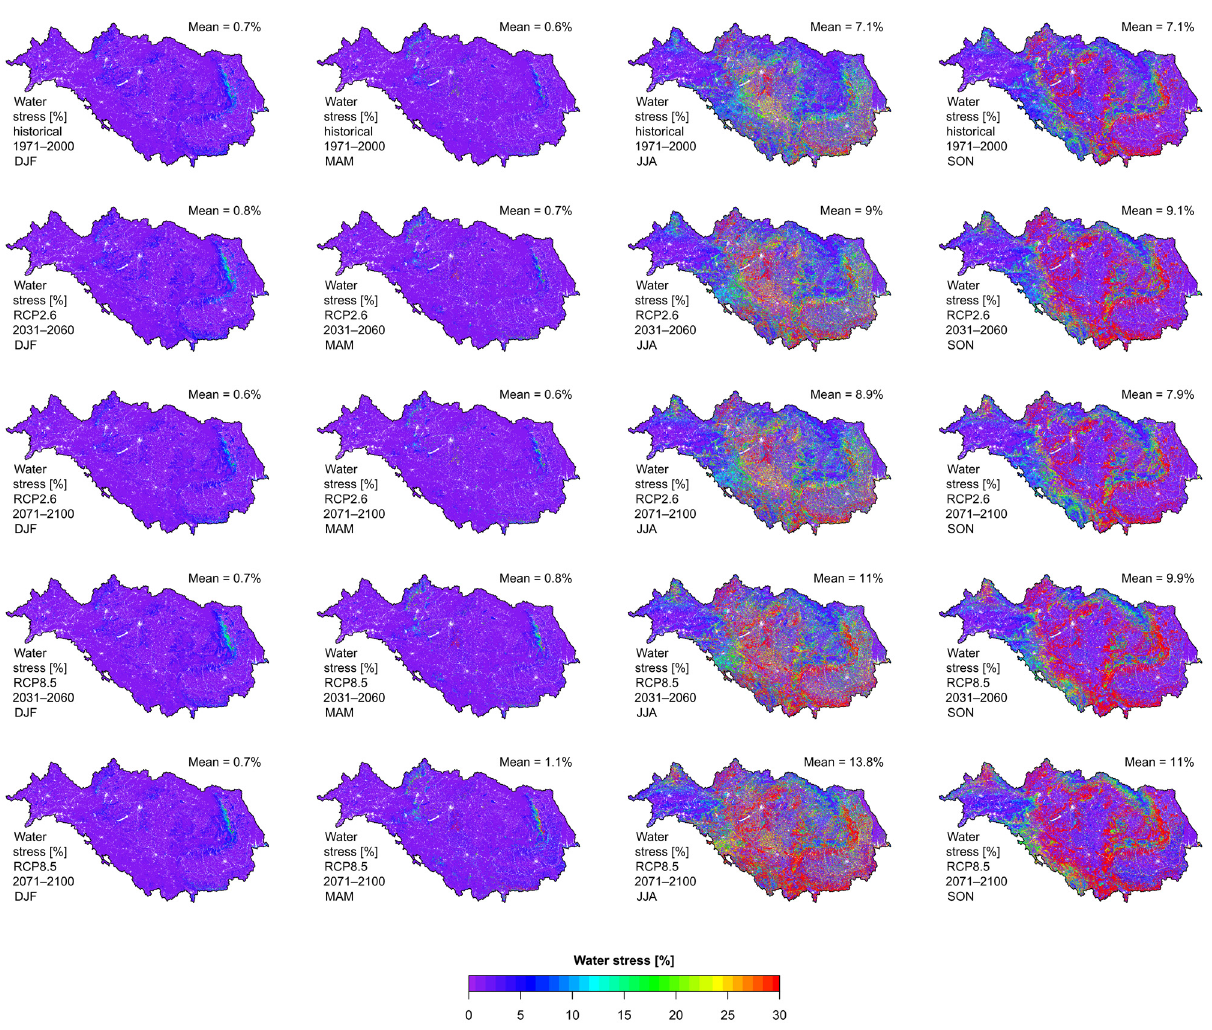
Figure 10. Maps of the long-term mean seasonal plant water stress [% reduction of potential transpiration] for the historical GCM-RCM-driven simulations (ensemble mean, 1971–2000) as well as for the GCM-RCM-driven simulations (ensemble mean) under RCP2.6 and RCP8.5 for the near future (2031–2060) and the far future (2071–2100) in the Danube River Basin.